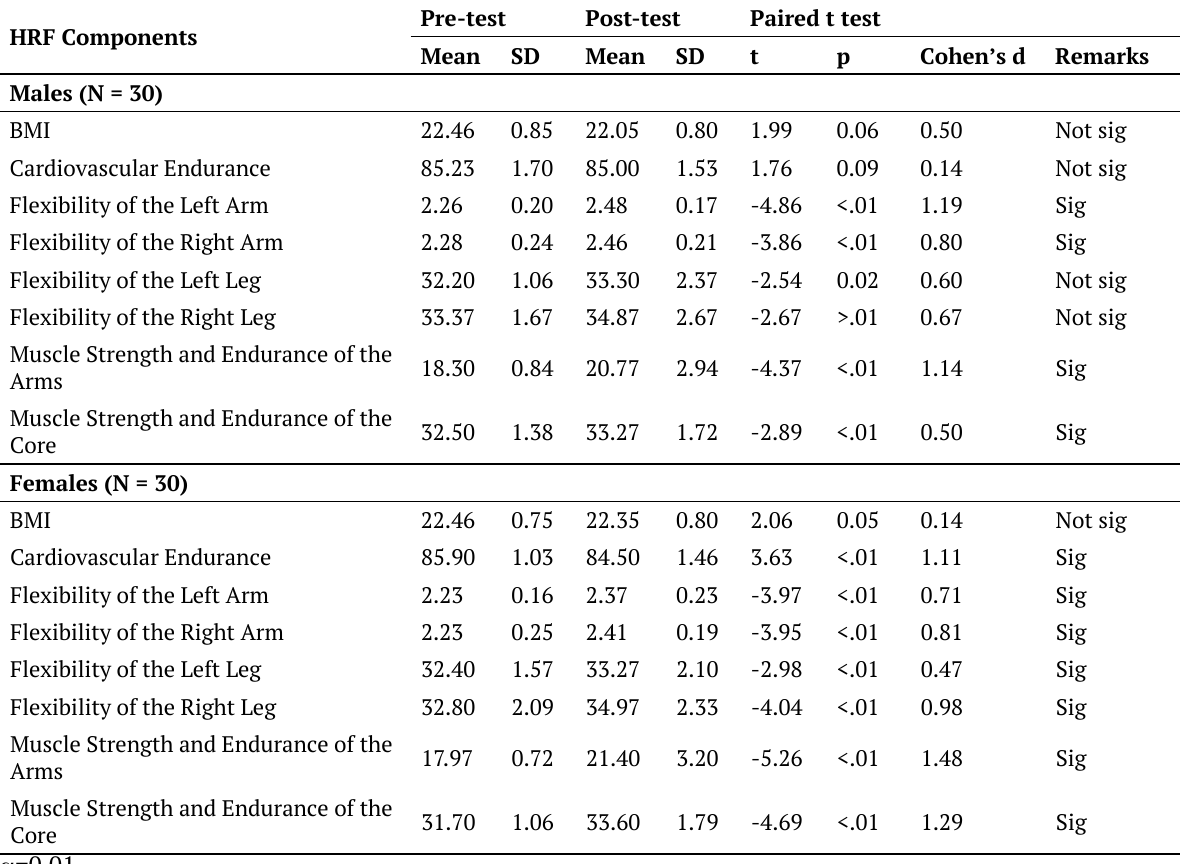
Table 3. Significant difference of the Pre- test and post-test scores of participants (male vs. male, female vs. female) in the HBE